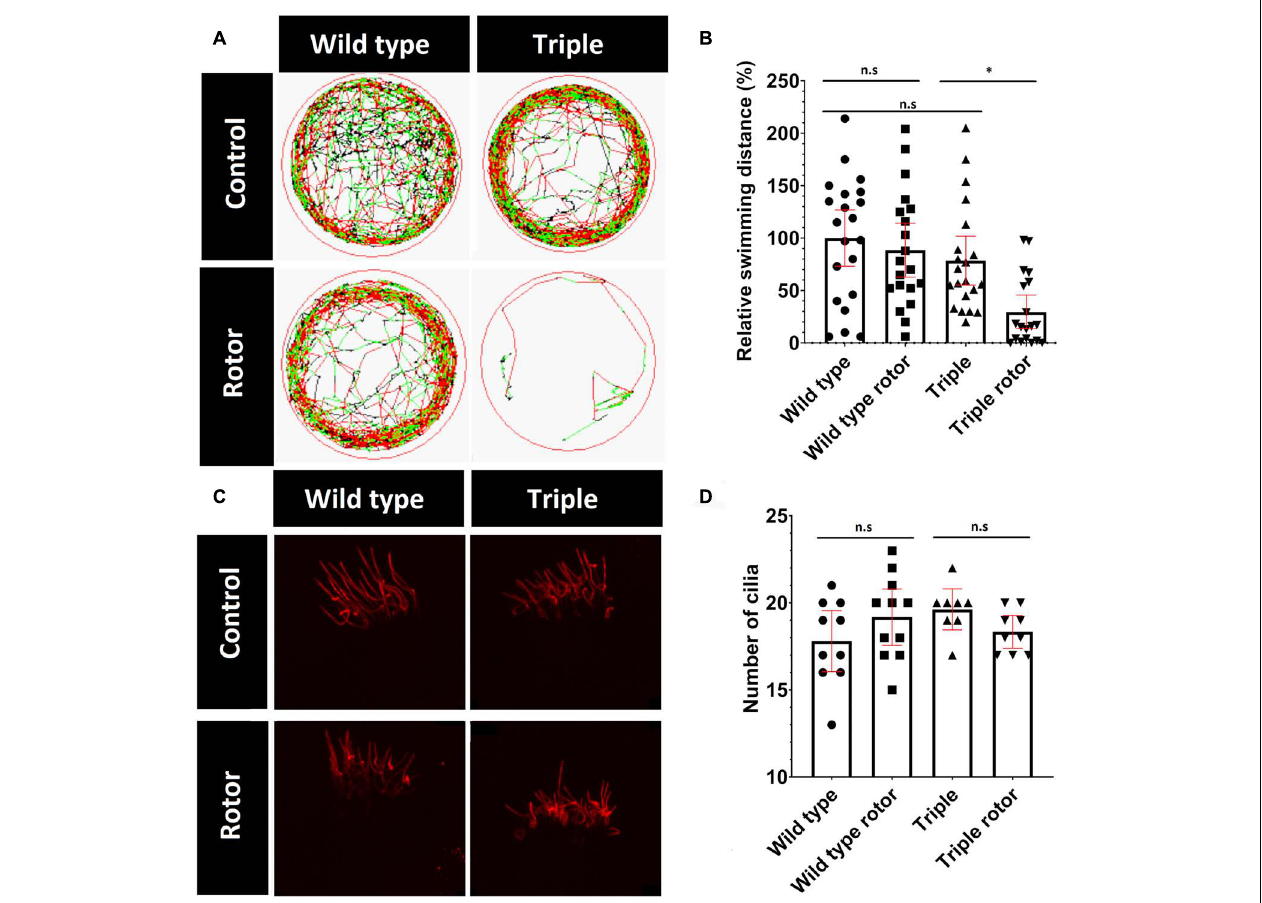
FIGURE 7 | Change in mutant behavior. (A) Tracks of swimming patterns of Wild type and Triple mutant fish treated and untreated with disorientating stimulus. Black lines correspond to slow swimming ( < 5 mm/s), green lines indicate medium speed (5–10 mm/s) and red lines indicate fast swimming ( > 10 mm/s). The figure shows a representative swimming pattern of one larvae. (B) Swimming distance normalized to swimming distance by non-treated wild types. (C) TAP952 stained cilia in cristae of treated and untreated fish. (D) Number of cilia in cristae (mean with 95% CI. T -test * p < 0.05). ns, no